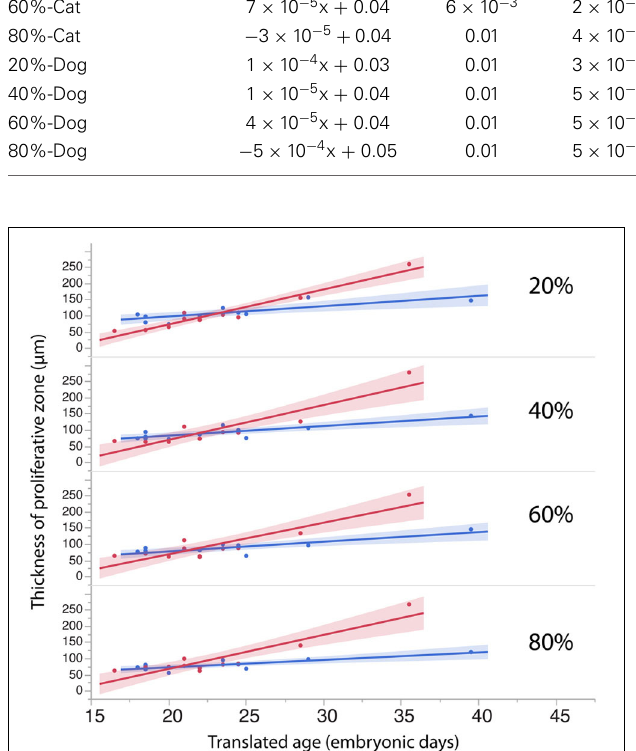
FIGURE 7 | The thickness of the progenitor population in rostral (20%) and more caudal regions (60–80%) of the cortex have a tendency to increase more over time in dogs than in